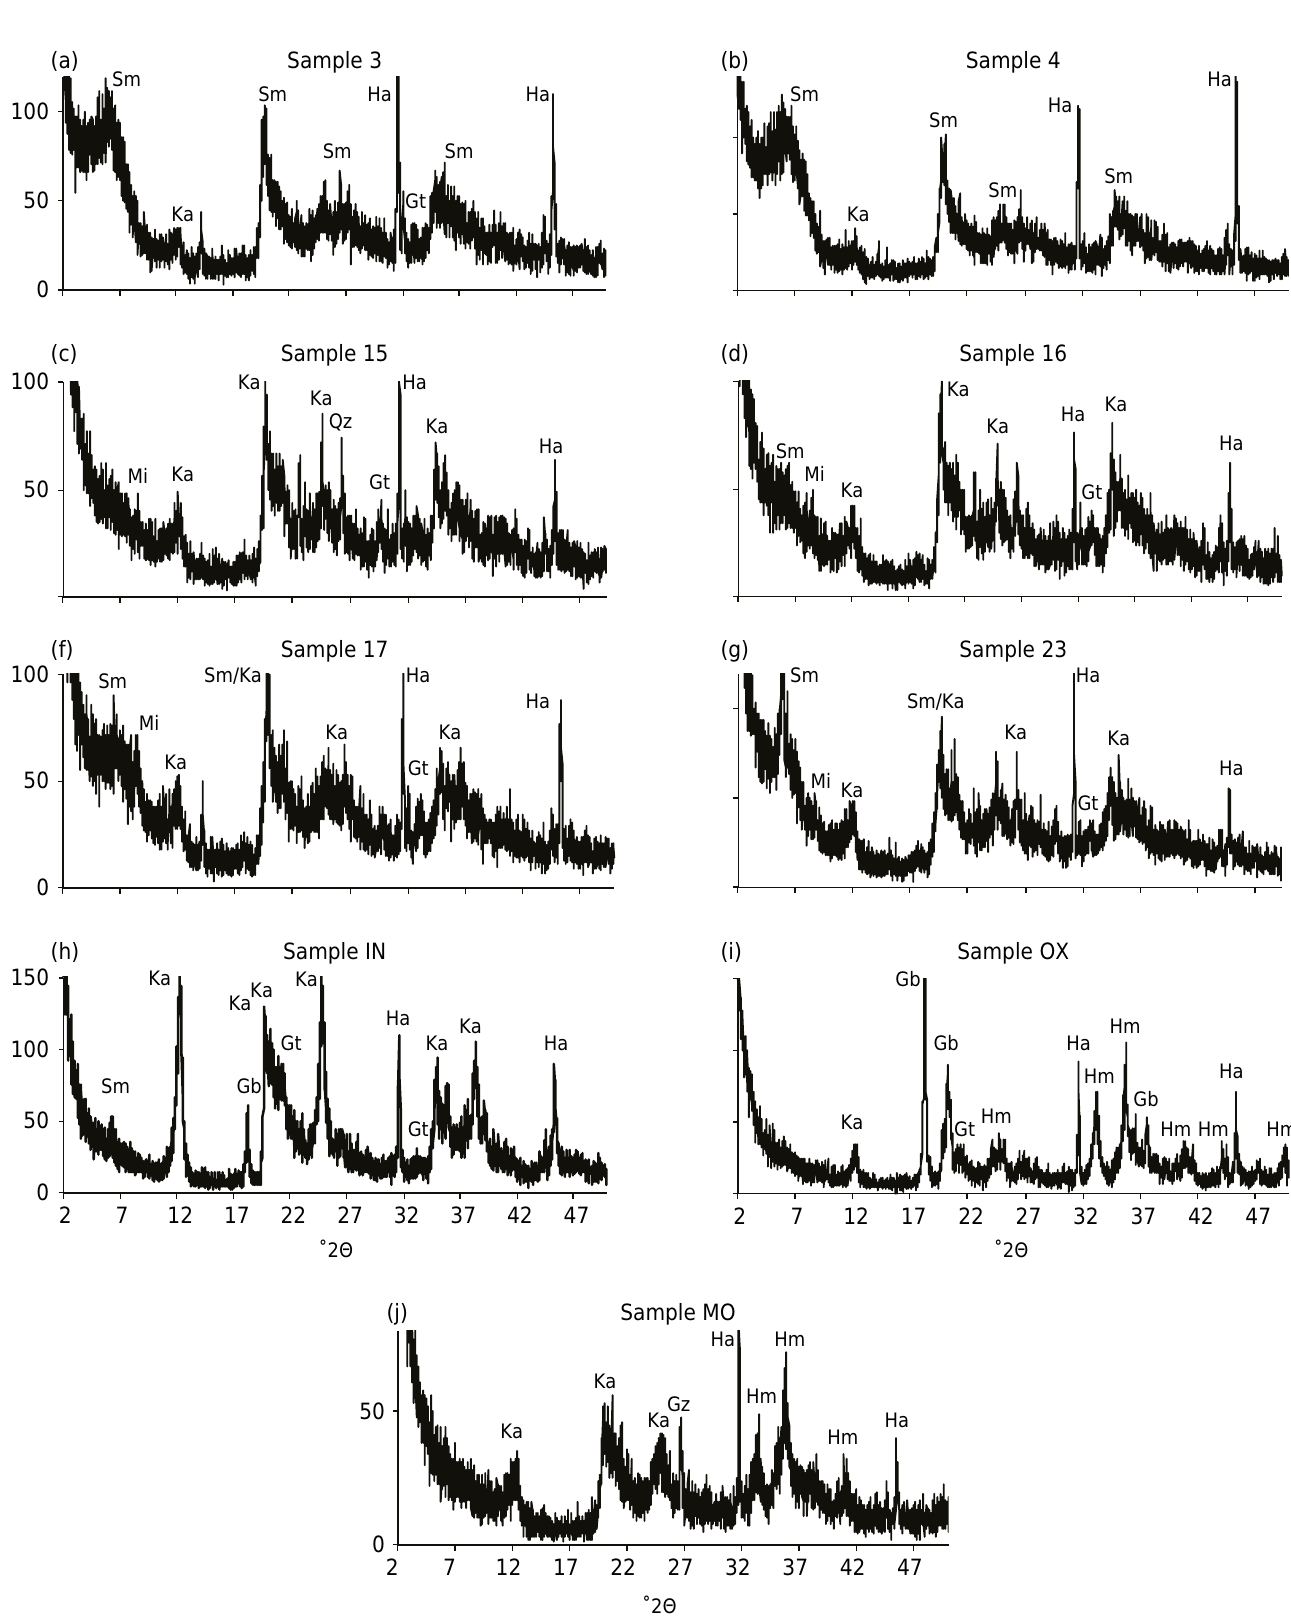
Figure 1. X ray diffraction patterns (CuKα radiation) of clay samples. Ka: kaolinite; Sm: smectite; Gb: gibbsite; Gt: goethite; Hm: hematite; Qz: quartz; Mi: mica; Ha: halite (halite does not belong to the soil clay fraction - this mineral was added to the samples as internal standard for correction of the peaks positions). IN: Inceptisol; OX: Oxisol; MO: